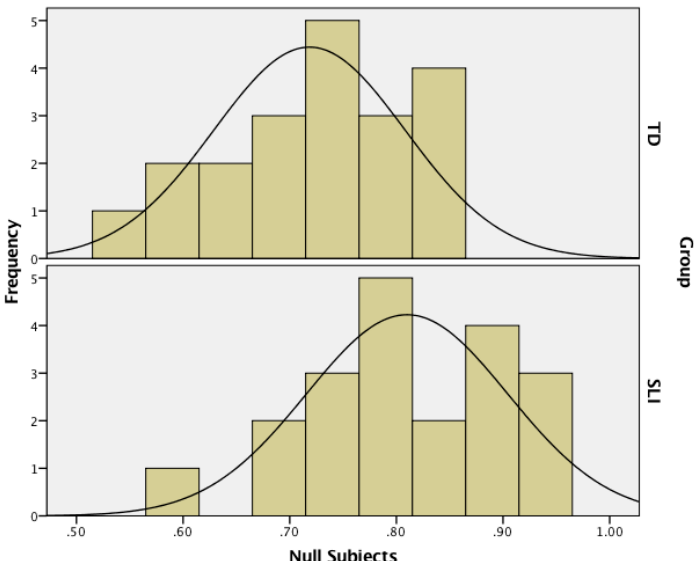
Figure 2. Histogram of rates of null subject use in the specific language impairment (SLI) and age-matched typically-developing control group, in normal distribution (Kolmogorov-Smirnov with Lilliefors significance correction and Shapiro–Wilk p values are > 0.05 for both groups). TD: typically developing. Table 6. Five discriminant functions including subject expression, MLUw, grammaticality choice and elicited production tense results.